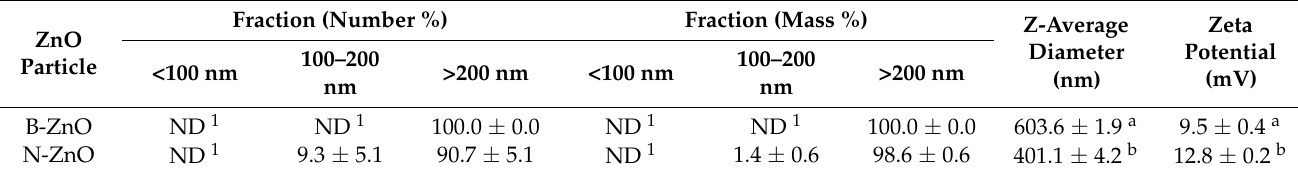
Table 1. Particle fractions, hydrodynamic diameters, and surface charges of ZnO particles. ZnO